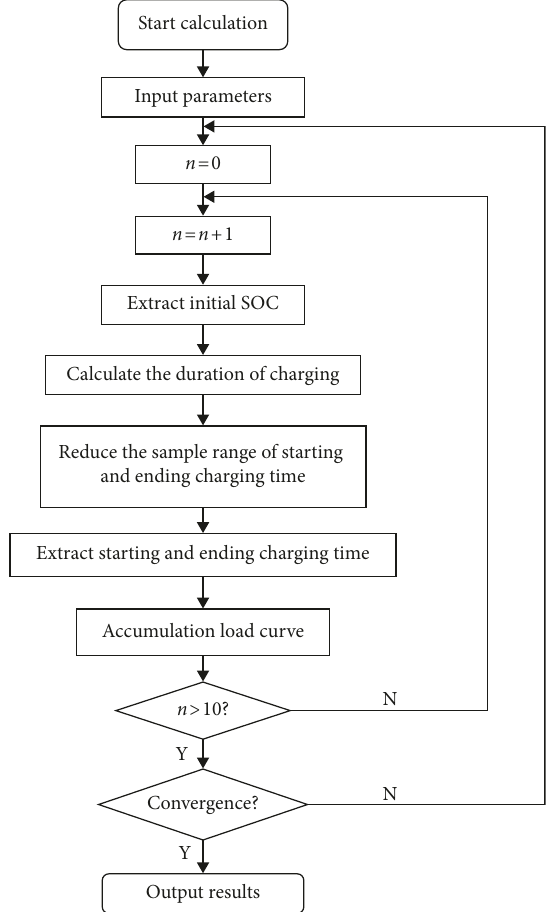
Figure 2: The flowchart of PEVs charging based on the Monte Carlo simulation